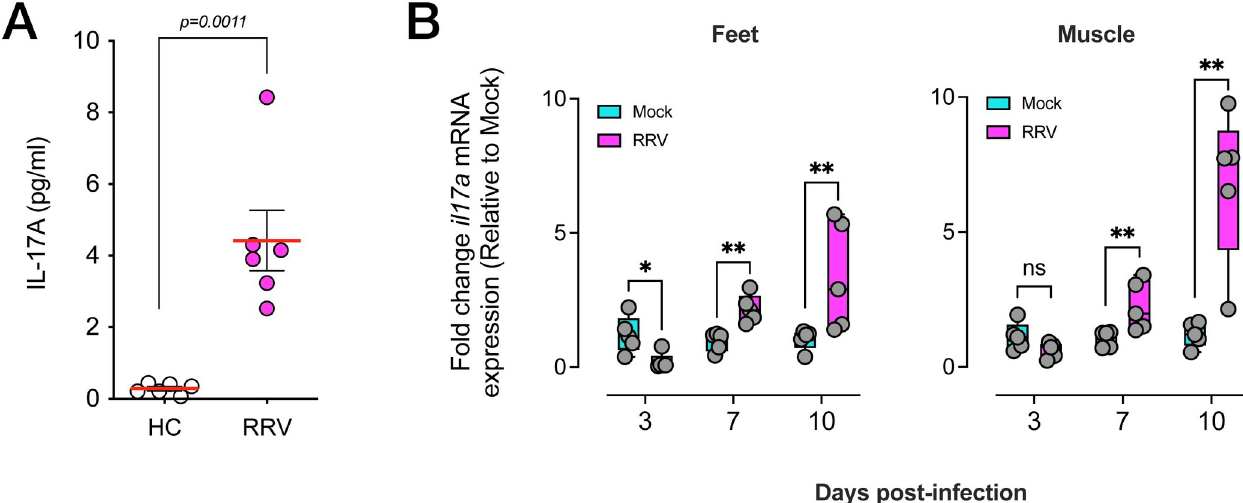
Fig 1. IL-17 is associated with RRV-induced arthritic disease in humans. A) Soluble IL-17A protein levels in the serum of healthy control (HC) and RRV- infected patients. Patient details described in Materials and Methods. Statistical analysis of differences between groups determined using a Mann-Whitney U test. B) mRNA expression of Il17a in the feet and muscle (quadriceps) of RRV-infected IL-17 GFP mice, at 3, 7 and 10 dpi. Expressed as fold-change relative to gene expression in mock-infected mice, and normalized to housekeeping gene expression, presented as mean +/- SEM. �� p < 0.01, Mann-Whitney U test. Data shows 3 independent experiments (n = 5 mice per